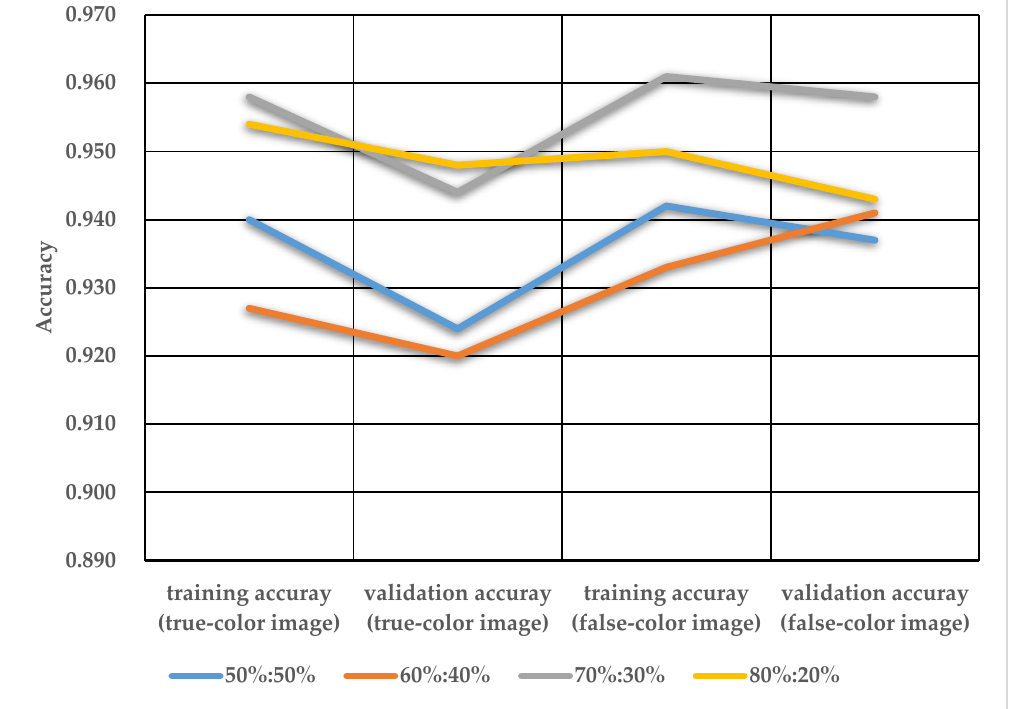
Figure 9. Training and validation accuracies of the true-color image and false-color image under different batch sizes.